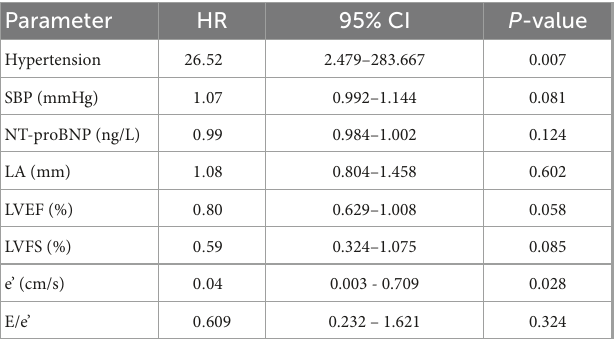
TABLE 6 Multivariate regression analysis with